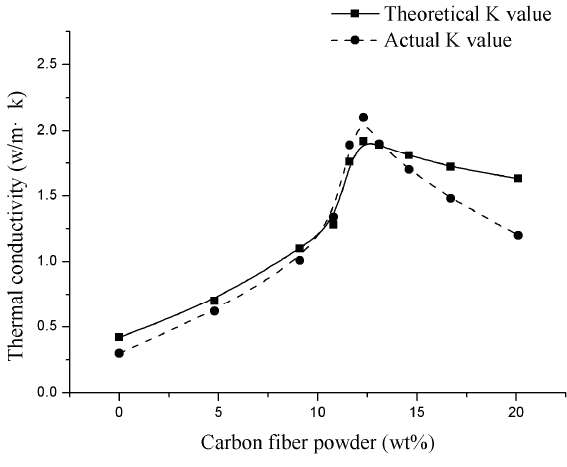
Figure 6. Comparison between theoretical value and actual test results of coating thermal conductivity.